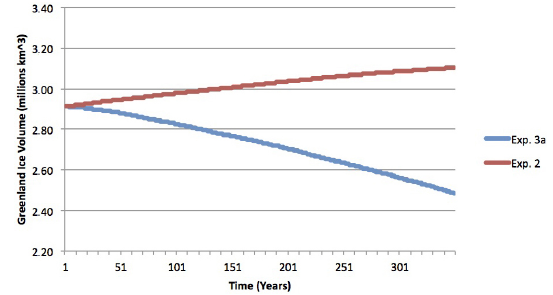
Figure 7. Ice volume decrease of the Greenland Ice Sheet in Exp.